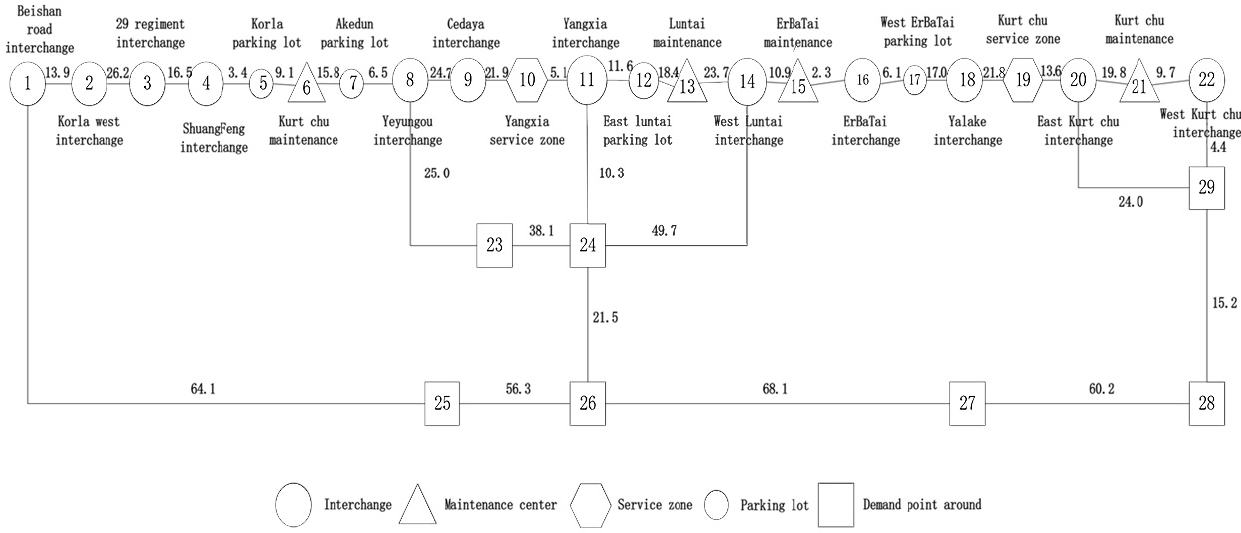
Figure 4. Regional sparse network in Aksu ‐ Korla.